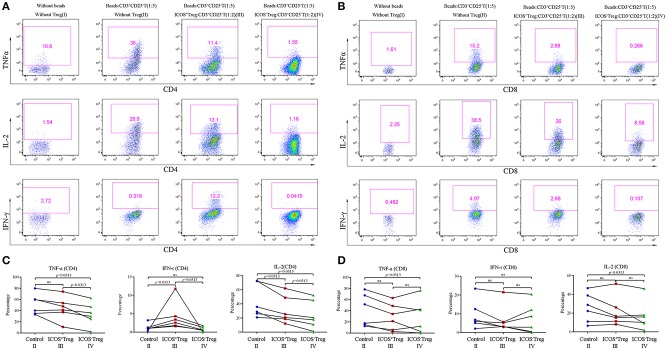
Co-culture experiments of CD3+CD25−T cells and Treg suubsets. (A,B) Effector CD3+CD25−T cells were cultured with or without Treg subsets and CD3+CD28+ dynabeads (ratios were shown in the parenthesis) for 3 days, the representative flow cytometry images of cytokines secretion were shown as above. (C,D) Cytokines including TNF-α, IL-2, and IFN-γ produced by CD4+ and CD8+T cells in the control (II), ICOS+Treg (III), and ICOS−Treg (IV) systems were analyzed. Wilcoxon test was used.